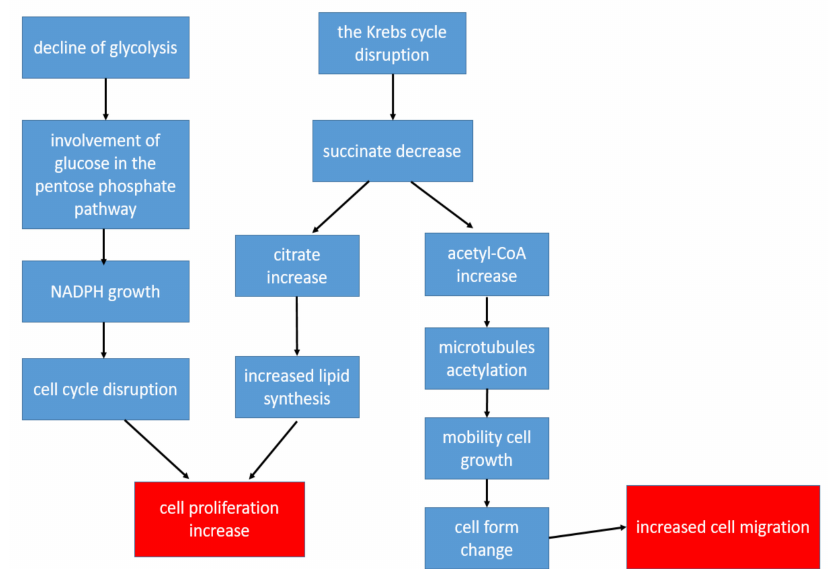
Figure 2. The key changes in the metabolism of T-helper cells leading to increased